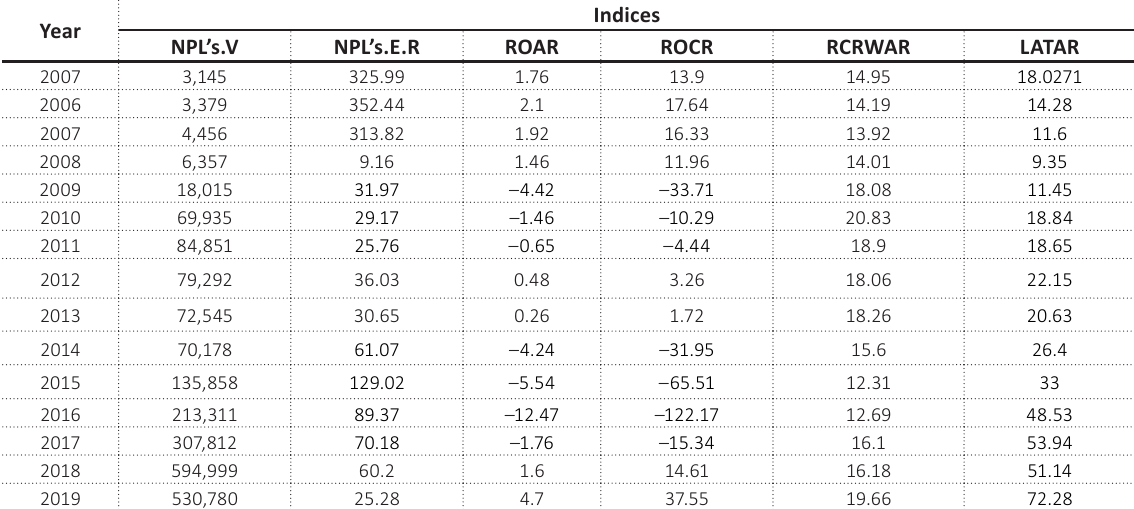
Table 2. Statistic data to study the relationship between banking institutions’ nonperforming loans, profitability and financial stability of the Ukrainian banking sector for